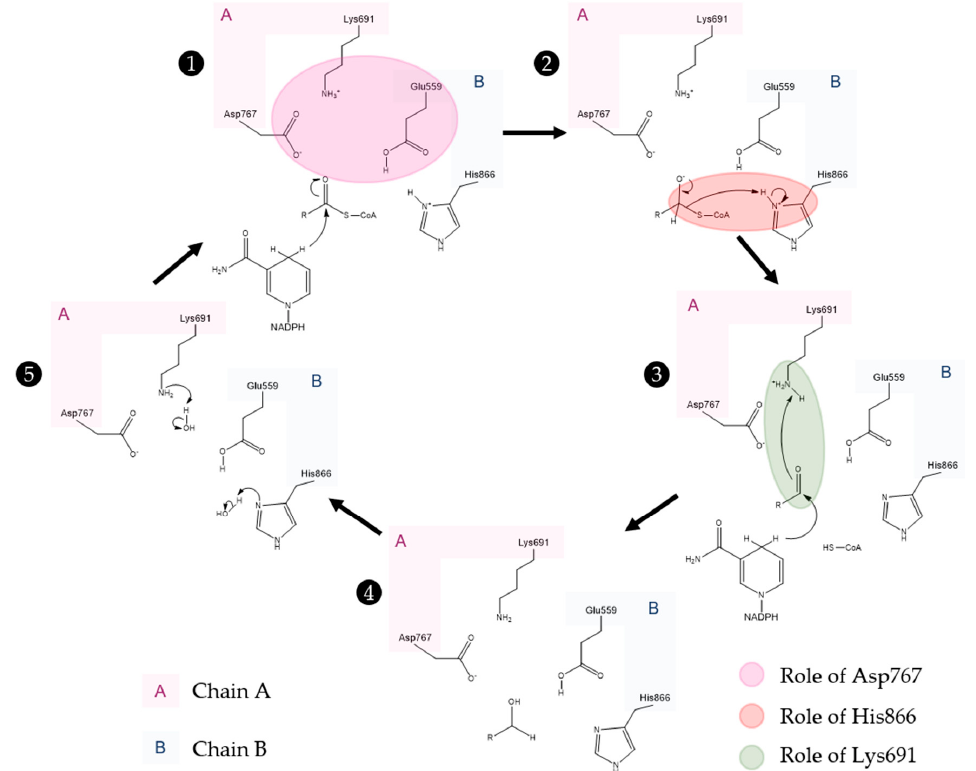
Figure 11. Currently accepted catalytic mechanism of HMG-CoAR [56]. The catalytic residues are Lys691, Glu559, Asp767 and His866; chain A is highlighted in pink and chain B is highlighted in